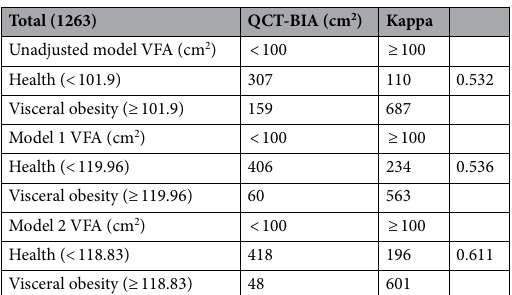
Table 7. The consistency of the VFA between BIA and QCT using the Kappa method according to health and visceral